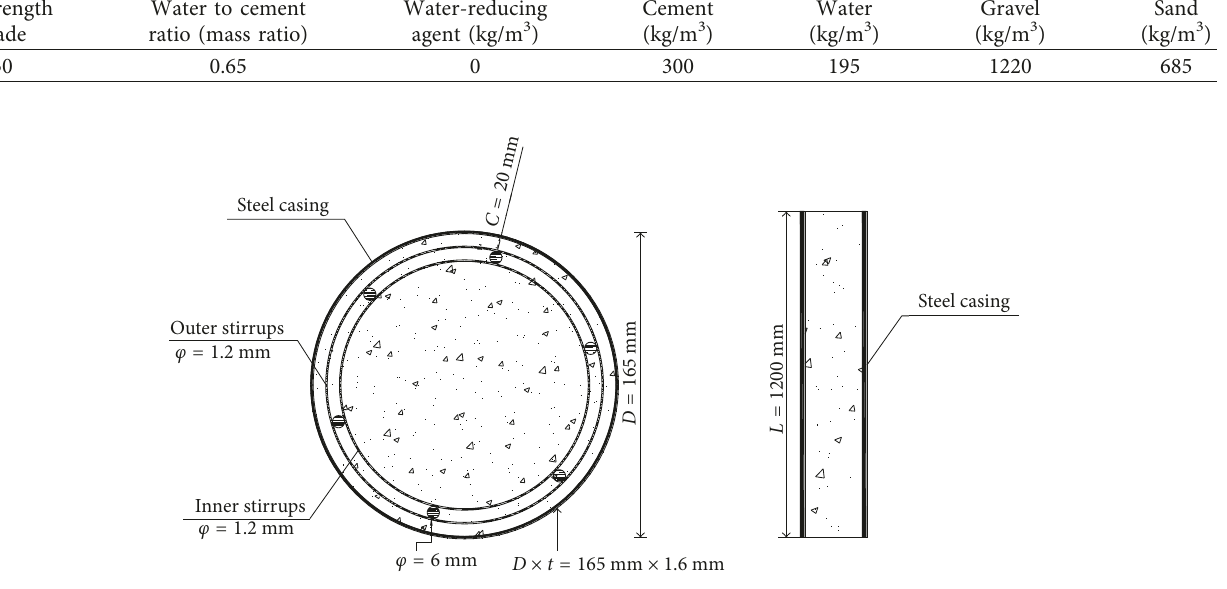
Figure 1: Specimen